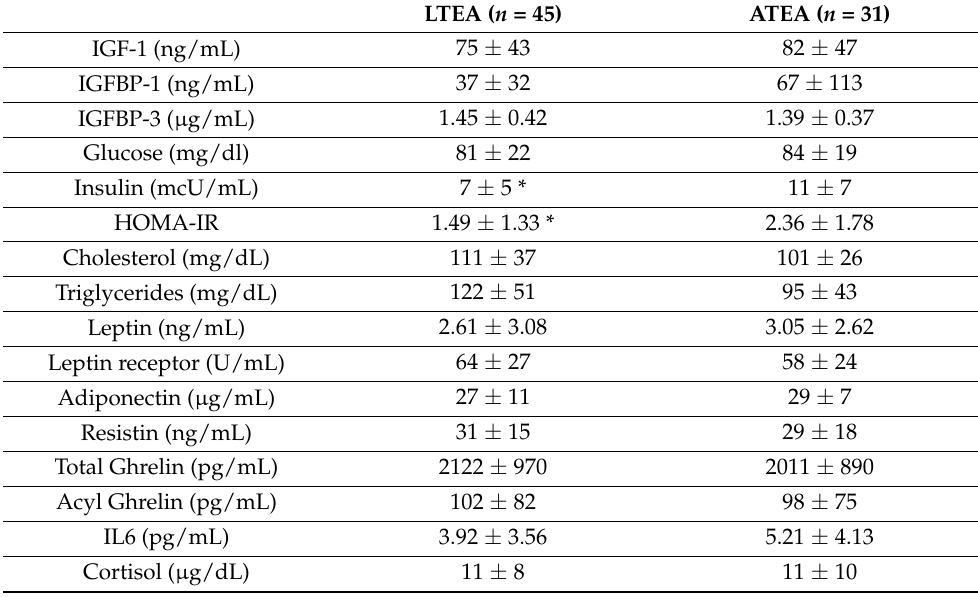
Table 2. Basal serum values of IGF1, IGFBP1, IGFBP3, glucose, insulin, HOMA-IR, cholesterol, triglycerides, leptin, leptin receptor, adiponectin, resistin, total ghrelin, acyl ghrelin, IL-6, and cortisol at 36 weeks in LTEA and ATEA infants. LTEA ( n = 45) ATEA ( n = 31) IGF-1 (ng/mL) 75 ± 43 82 ± 47 IGFBP-1 (ng/mL) 37 ± 32 67 ± 113 IGFBP-3 ( µ g/mL) 1.45 ± 0.42 1.39 ± 0.37 Glucose (mg/dl) 81 ± 22 84 ± 19 Insulin (mcU/mL) 7 ± 5 * 11 ± 7 HOMA-IR 1.49 ± 1.33 * 2.36 ± 1.78 Cholesterol (mg/dL) 111 ± 37 101 ± 26 Triglycerides (mg/dL) 122 ± 51 95 ± 43 Leptin (ng/mL) 2.61 ± 3.08 3.05 ± 2.62 Leptin receptor (U/mL) 64 ± 27 58 ± 24 Adiponectin ( µ g/mL) 27 ± 11 29 ± 7 Resistin (ng/mL) 31 ± 15 29 ± 18 Total Ghrelin (pg/mL) 2122 ± 970 2011 ± 890 Acyl Ghrelin (pg/mL) 102 ± 82 98 ± 75 IL6 (pg/mL) 3.92 ± 3.56 5.21 ± 4.13 Cortisol ( µ